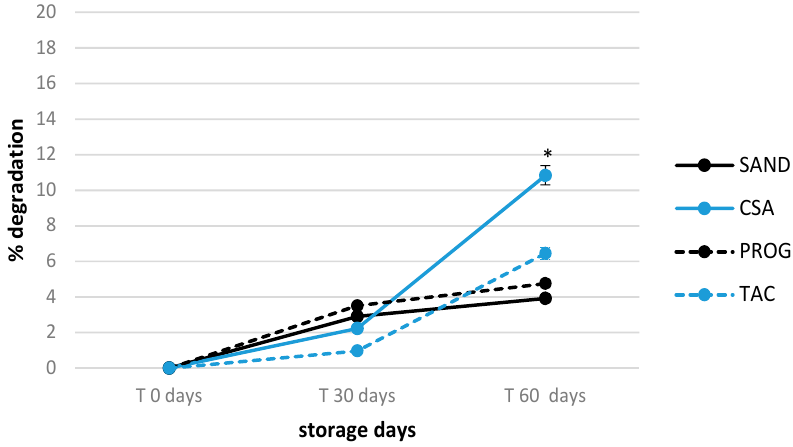
Figure 3. Active principle stability during 60 days in 0.1% tacrolimus and 1.0% cyclosporine A unopened eye drop formulations stored at 5 °C; * p < 0.05, T.amb versus 5 °C storage temperature.